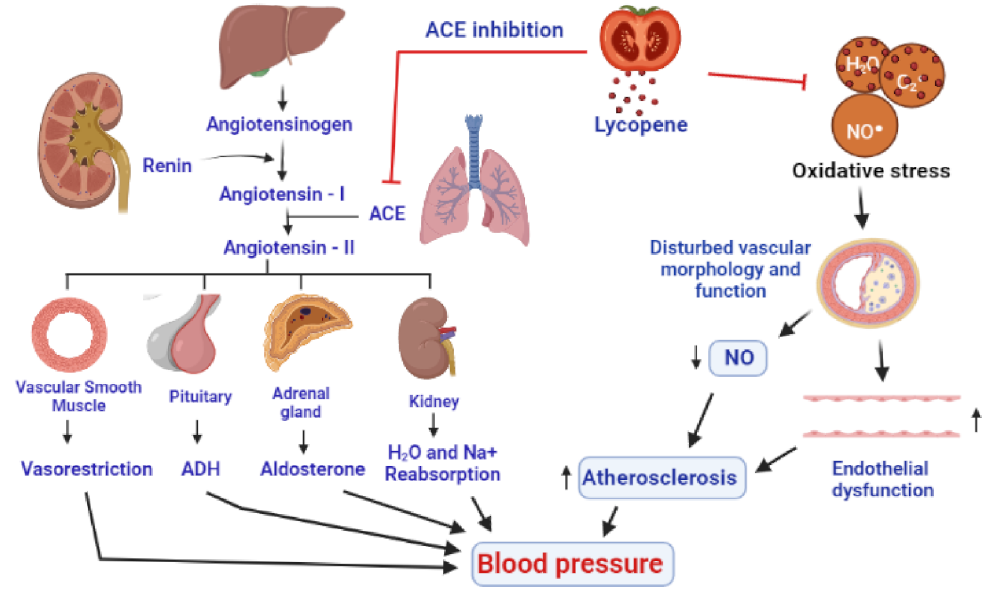
Figure 6. A presentation of antihypertensive effects of lycopene by inhibition of ACE (angiotensin- converting enzyme) and through an antioxidant activity to inhibit the action of ROS on the linings of the blood vessels, resulting in the improvement of nitric oxide levels and the functioning of endothelium. Eventually, a decrease in vasoconstriction, inhibition of antidiuretic hormone and aldosterone, and decrease in the reabsorption of water and Na + by the kidneys decrease the blood